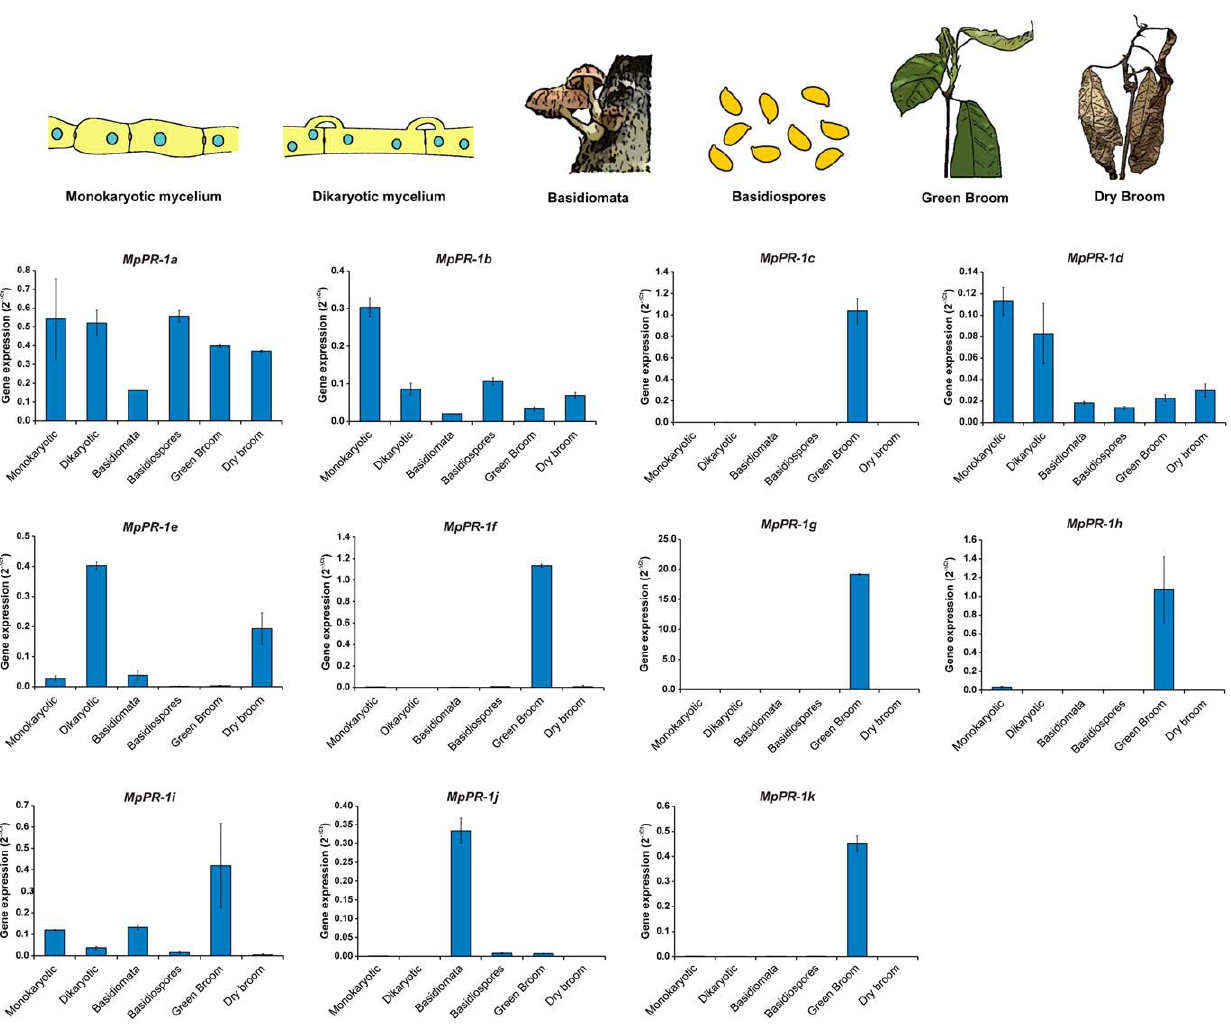
Figure 4. Transcriptional profile of MpPR-1 family members throughout the M.perniciosa life cycle. Each MpPR-1 gene has a distinct expression profile during fungal development. ‘‘Monokaryotic’’ and ‘‘Dikaryotic’’ hyphae represent the two mycelial stages (biotrophic and necrotrophic) grown under in vitro conditions. ‘‘Green broom’’ and ‘‘dry broom’’ correspond to the biotrophic and necrotrophic stages of M. perniciosa , respectively, during its interaction with cacao. Analyses were performed by qPCR and the M. perniciosa b -actin gene was used as endogenous control to normalize data. Error bars represent standard deviations determined with two biological replicates. Representative drawings of the conditions analyzed are shown on the